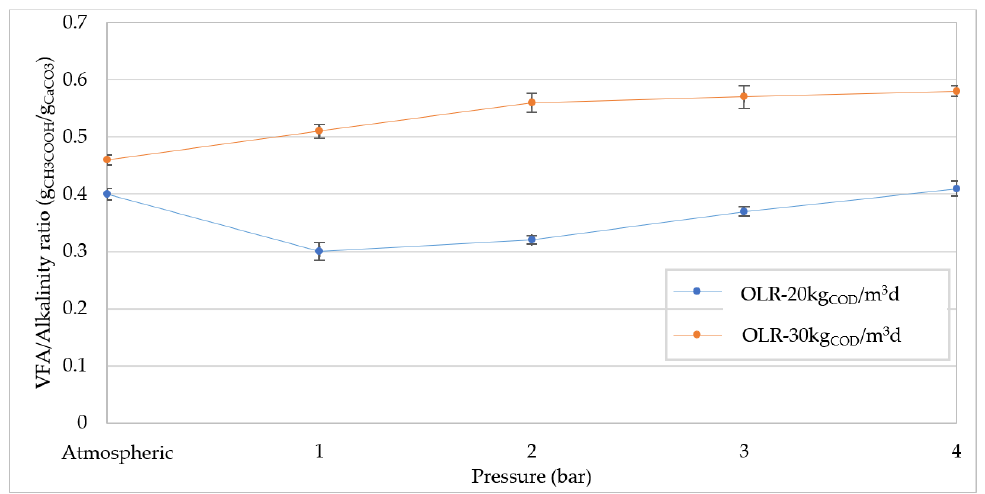
Figure 10. Volatile fatty acids/Alkalinity ratio at increasing pressures for organic load rate (OLR) of 20 kg COD /m 3 d and 30 kg COD /m 3 d.